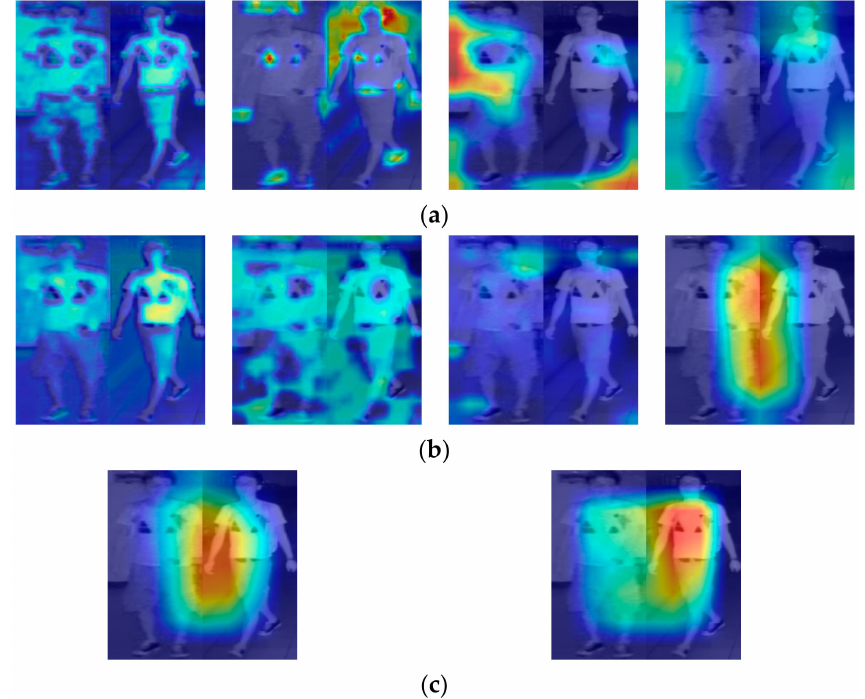
Figure 13. Grad-cam images obtained by the original DenseNet, attention-guided DenseNet, and SCE-Net in case of genuine matching. Grad-cam images extracted from ( a ) the original DenseNet, and ( b ) the attention-guided DenseNet. Grad-cam images extracted from dense blocks 1 to 4 in Tables A1 and A2 (Appendix A) are arranged from left to right in ( a , b ). ( c ) Grad-cam images extracted from the SCE-Net where the left-side images were extracted from conv layer 1 of Table A3 (Appendix A), while the right-side images were extracted from conv layer 2. In ( a – c ), the left-hand side of the composition image is the enrolled image, while the right-hand side is the input query image.